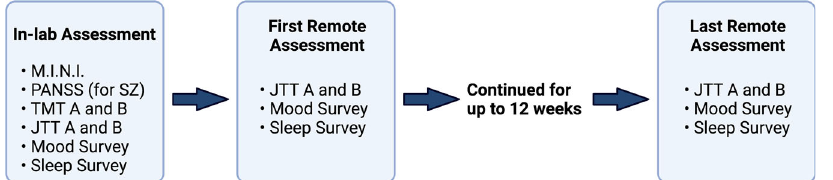
Fig. 5 Timeline of the study procedures. M.I.N.I MINI International Neuropsychiatric Interview, PANSS Positive and Negative Syndrome Scale, TMT Trail Making Tests, JTT Jewels Trail Tests. The time of the last remote assessment differs per participant based on the number of times they completed the JTT A and B over the 12-week study